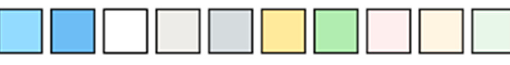
Figure 3. The Google Map color scheme.